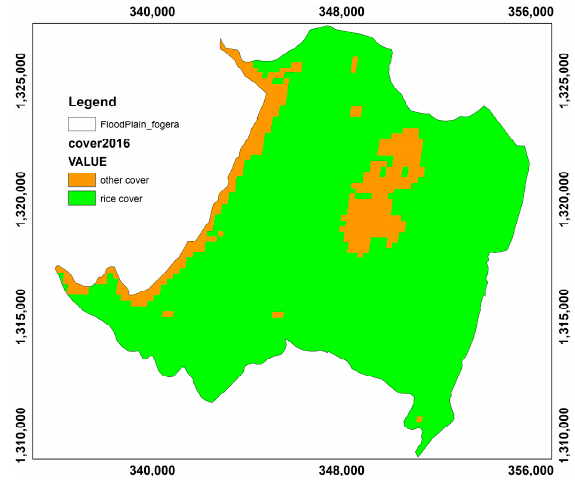
Figure 5. Rice verse other land use in Fogera floodplain.